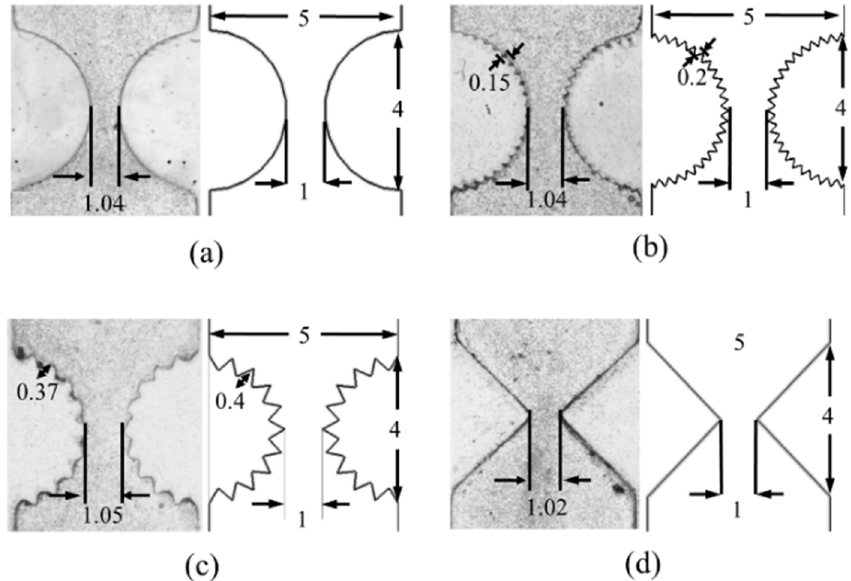
Figure 4. Picture of the manufactured pore and designed geometry ( a ) smooth circular pore, ( b ) sharp pore, ( c ) circular pore with 0.2 mm roughness, and ( d ) circular pore with 0.4 mm roughness (all dimensions are in mm).